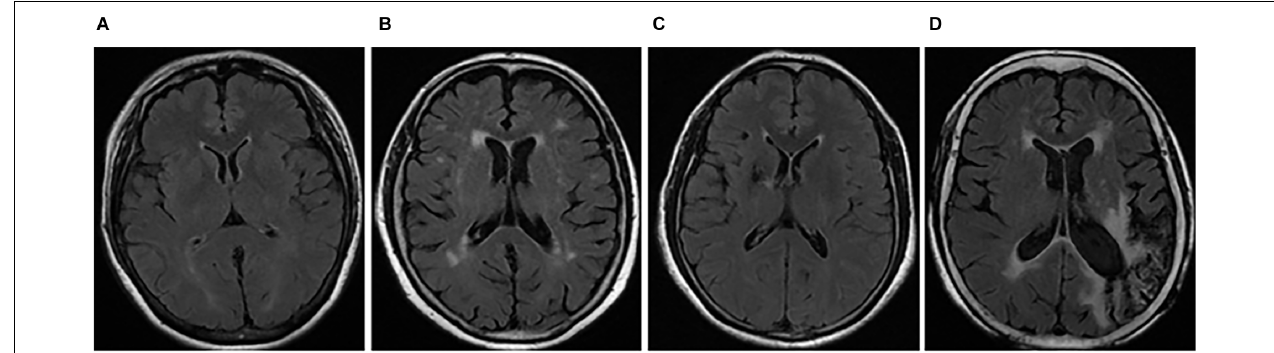
FIGURE 2 | Typical WMH images in patients with CSVD and stroke. T2WI-FLAIR MRI sequences were analyzed in the patients with CSVD and/or stroke. The total Fazekas scores of typical patients with CSVD were 1 (A) and 4 (B) , and those of typical stroke patients with infarction of the right basal ganglia and left occipital lobe were 1 (C) and 4 (D) , respectively. Panels (A,C) were identified as mWMH, and (B,D) as sWMH. CSVD, cerebral small vessel disease; mWMH, mild white matter hyperintensities; NC, normal cognition; sWMH, severe white matter